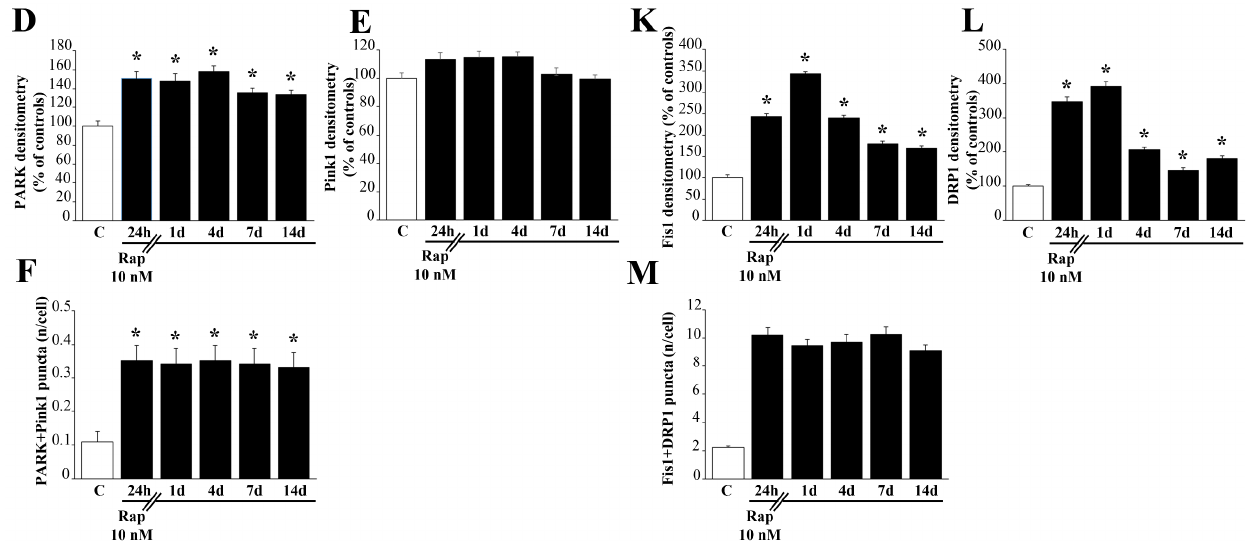
Figure 7. Rapamycin increases autophagy-related mitochondrial dynamics. ( A ) Representative pictures show that rapamycin increases histofluorescence of MTR-G and immuno-fluorescence for LC3. Arrows point to merging (yellow) puncta. ( B ) Graph reports the rapamycin-induced long- lasting increase in MTR-G+LC3 merging puncta. ( C ) Representative pictures show mitophagy markers PARK and Pink1 from control and rapamycin-treated cells (10 nM at 1 day). Arrows point to merging (yellow) puncta. ( D ) The graph of PARK immunofluorescence indicates a long-lasting significant increase following rapamycin. ( E ) The graph shows no significant effect of rapamycin on Pink1 immunofluorescence at any time interval. ( F ) The graph indicates a significant increase in the number of puncta showing the merging of PARK and Pink1, which exceeds at large the increase induced in PARK immunofluorescence. ( G ) Representative pictures show that rapamycin increases histofluorescence of MTR-G and immunofluorescence for BNIP3 compared with control. Arrows point to merging (yellow) puncta. ( H ) Graph reports the rapamycin-induced long-lasting increase in BNIP3 immunofluorescence. ( I ) Graph reports the rapamycin-induced long-lasting increase in MTR- G+BNIP3 merging puncta. ( J ) Representative pictures of the fission markers Fis1 and DRP1. Arrows point to merging (yellow) puncta. Graphs ( K ) and ( L ) report Fis1 and DRP1 immunofluorescent intensity, respectively. Graph ( M ) reports Fis1 + DRP1 merging puncta. Values are given as the mean ± S.E.M from N = 100 cells per group. C=Controls * p < 0.05 compared with controls. Scale bars: ( A ) = 13 µ m; ( C ) = 20 µ m; ( G ) = 18 µ m; ( J ) = 13 µ